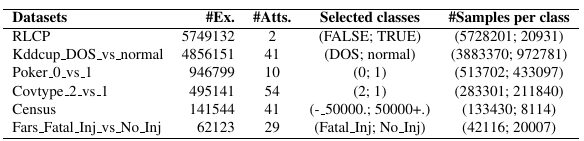
Table 1. Summary of datasets Datasets